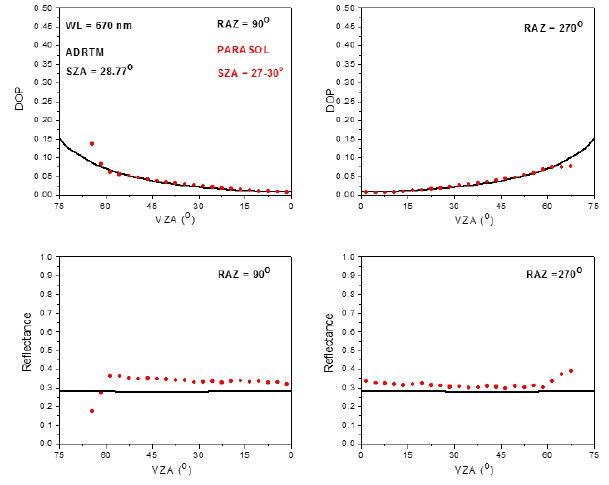
Figure 9. Same as in Fig. 8 but at RAZs of 90 and 270 ◦ .